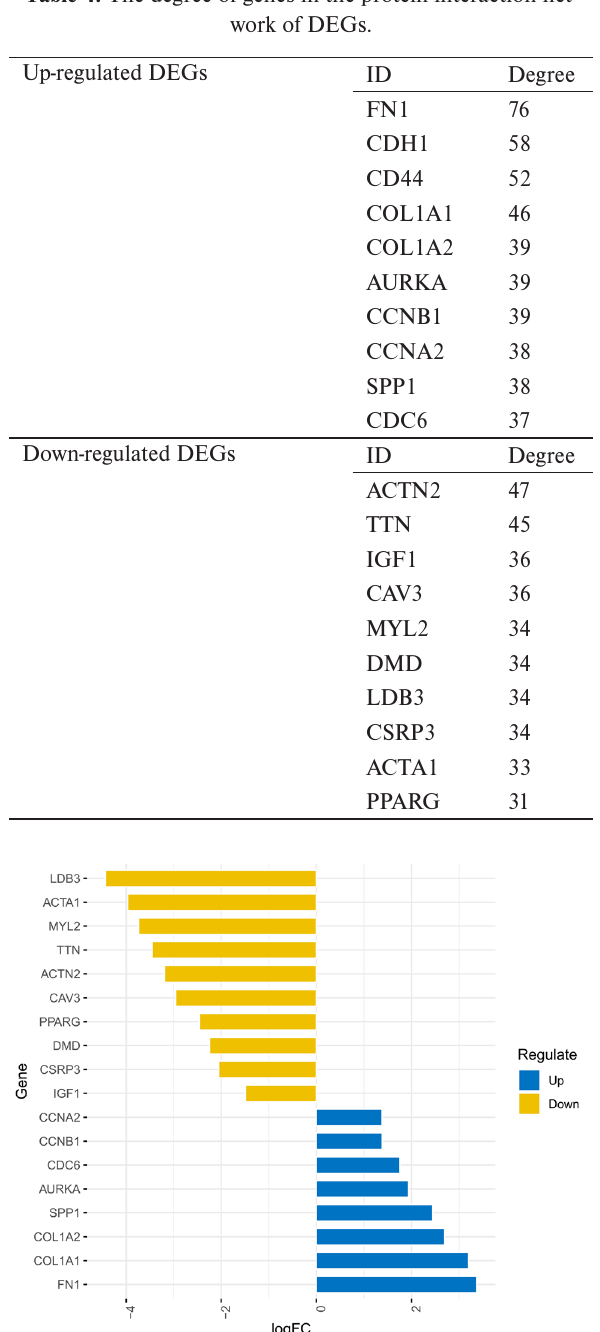
Table 4. The degree of genes in the protein interaction net- work of DEGs.